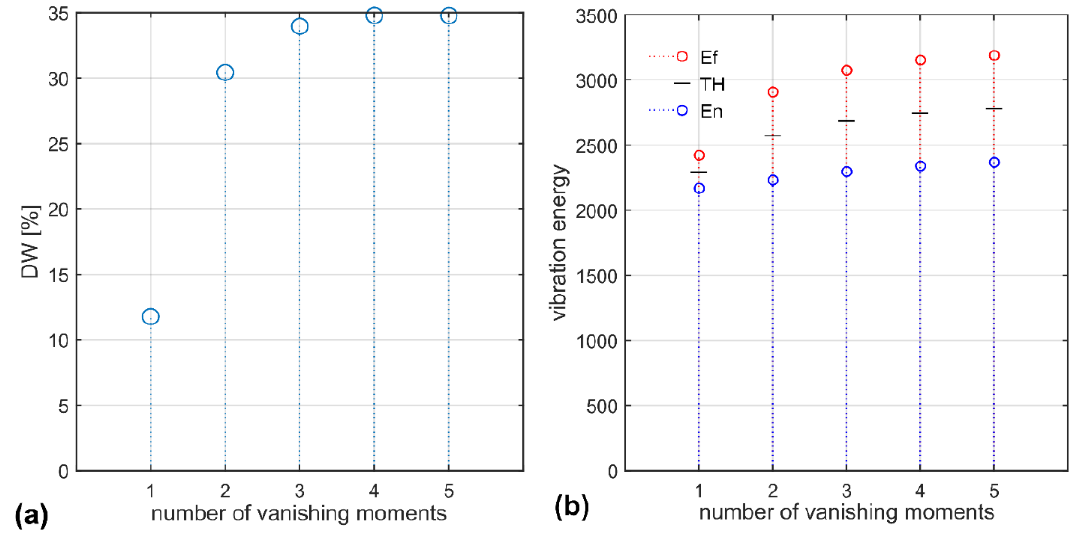
Figure 4. DW function values: ( a ) 7th decomposition level, Coiflets with 1–5 vanishing moments; ( b ) vibration energy calculated using coif5 wavelet (Ef-red circles: faulty wheel vibration energy; En-blue circles: normal wheel vibration energy) and threshold (TH-thresholding values of vibration energy difference between faulty and normal wheels).